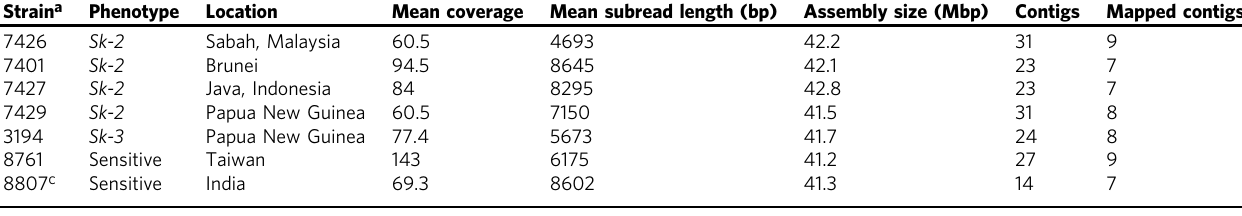
Table 1 PacBio sequencing and genome assembly statistics for seven N. intermedia